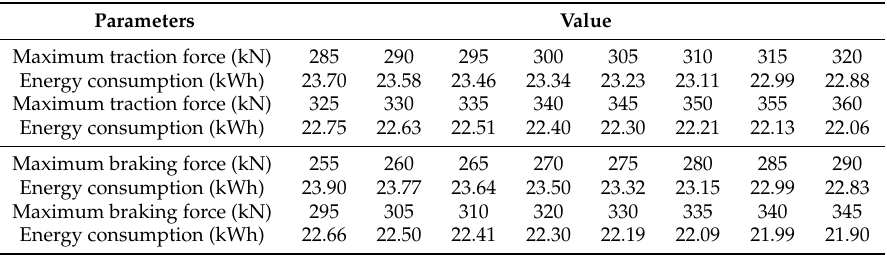
Table 10. Traction energy-saving performance with different maximum traction and braking forces.